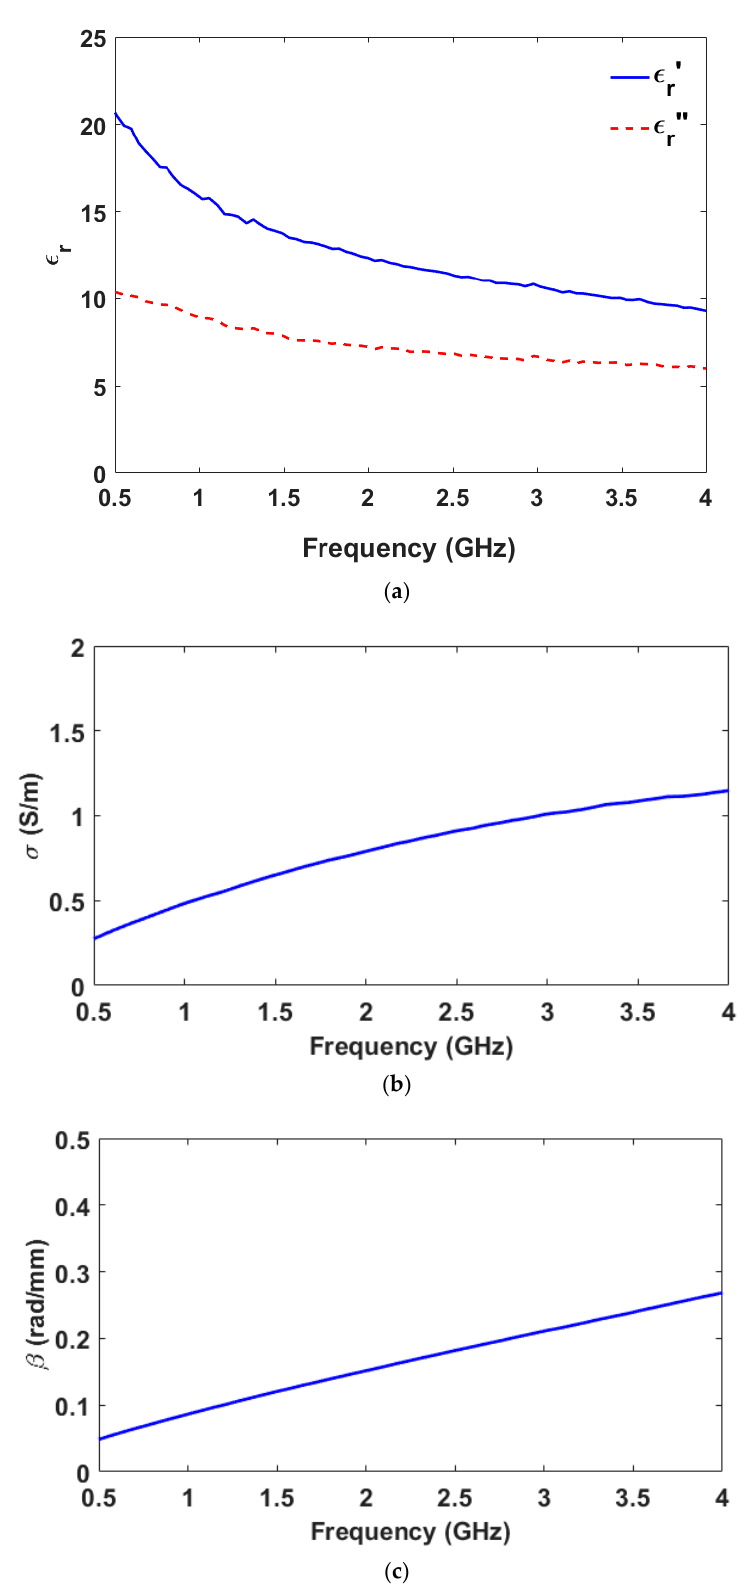
Figure 7. ( a ) Complex relative permittivity ( b ) electrical conductivity ( c ) phase constant of pure honey in the frequency range of 0.5–4.0 GHz at the temperature of 25 ◦